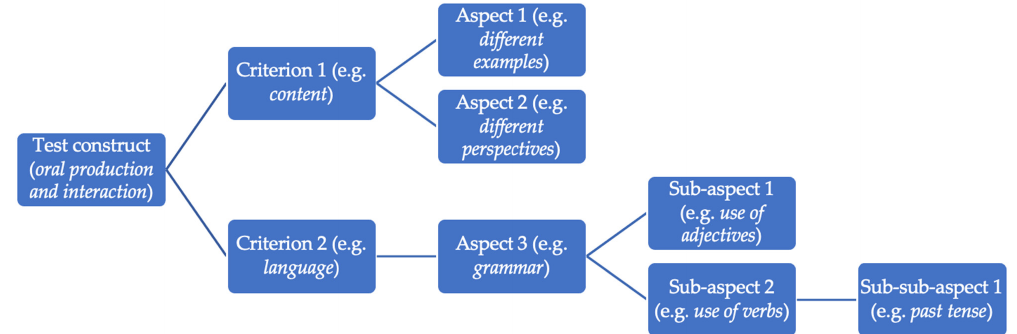
Figure 2. Tree Structure of Categories Criterion, Aspect, Sub-aspect, and Sub-sub-aspect.